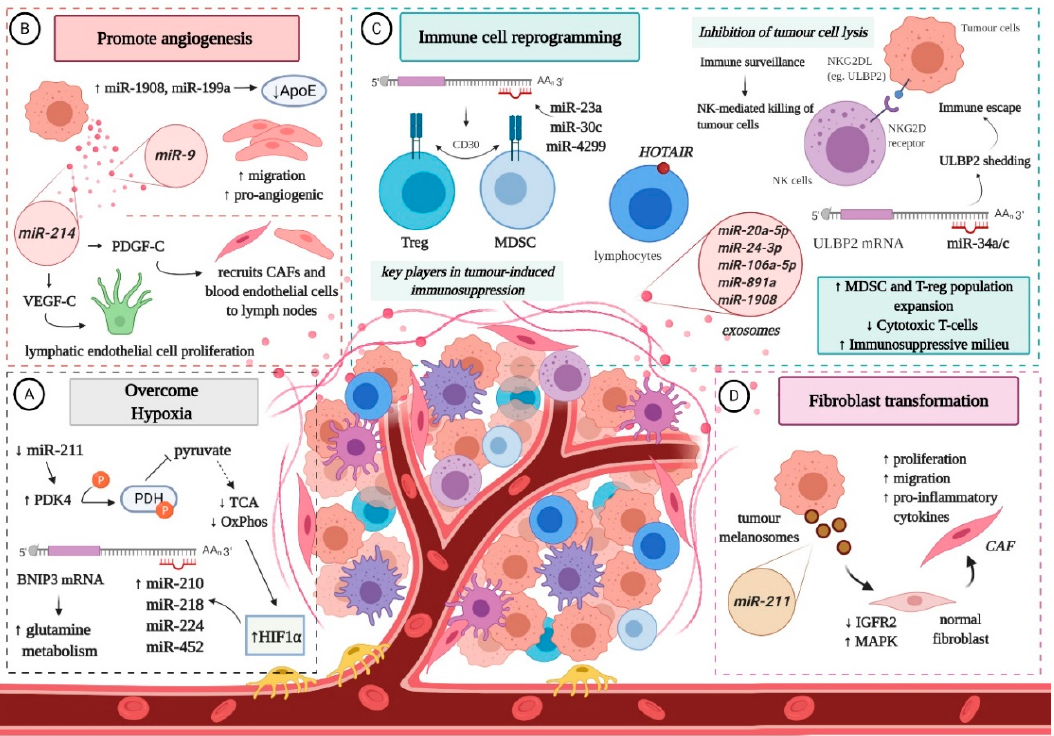
Figure 2. The interplay of non-coding RNAs with the melanoma microenvironment: ( A ) Melanoma cells overcome oxygen deprivation. Downregulation of miR-211 elevates PDK4 (pyruvate dehydrogenase kinase 4) levels, leading to the inhibition of PDH (pyruvate dehydrogenase) via phosphorylation, which in turn limits oxidative phosphorylation as pyruvate is rerouted away from the TCA (tricarboxylic acid cycle). Increased levels of HIF1 α (hypoxia-inducible factor 1 alpha) lead to the upregulation of several miRNAs that target BNIP3 (BCL2/adenovirus E1B interacting protein 3), stimulating glutamine metabolism; ( B ) MicroRNAs promote neo-angiogenesis. Certain miRNAs are upregulated in melanoma cells and distributed to endothelial cells via exosomes, in order to increase the migratory and pro-angiogenic potential of said cells and recruit them to the MME, found either in the cutaneous tissue or in lymph nodes; ( C ) Malignant melanocytes reprogramme immune cells to favour the establishment of an immunosuppressive microenvironment. In principle, miRNAs (often transported via exosomes) recruit and promote the expansion of MDSCs (myeloid-derived suppressor cells) and T-regs (regulatory T cells), inhibit cytotoxic T cells and trick NK (natural killer) cells by shedding soluble ligands in order to avoid tumour cell lysis. The role of HOTAIR in this case is uncertain, even though its overexpression was observed in the plasma membrane of lymphocytes associated with the MME; ( D ) Melanoma-derived melanosomes deliver miR-211 to normal fibroblasts, which inhibits the expression of IGFR2 (insulin-like growth factor receptor 2) and activates MAPK signalling, to transform them into cancer-associated fibroblasts (CAF) and prepare the dermis for future invasion. ApoE: Apolipoprotein E; PDGF-C: Platelet-derived growth factor C; VEGF-C: Vascular endothelial growth factor C; NKG2D: natural killer group 2, member D; ULBP2: UL16 binding protein 2. Figure created with BioRender.com.